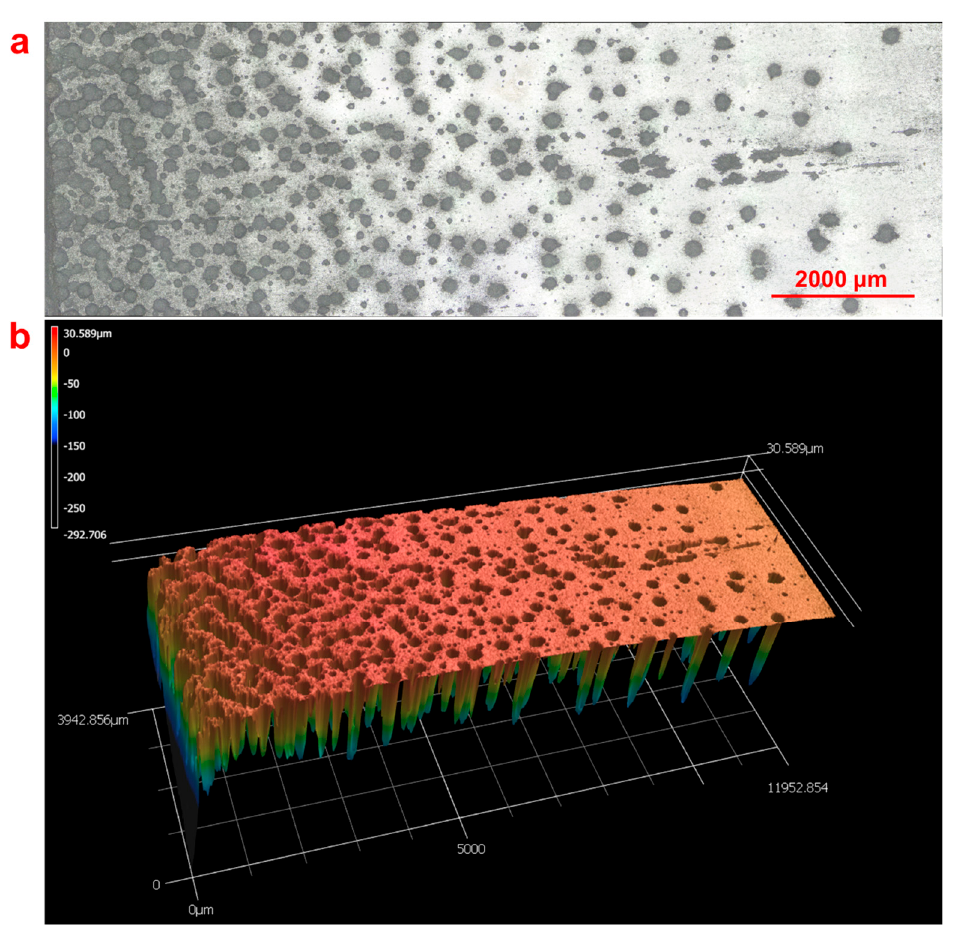
Figure 10. ( a ) The optical image of the pitting corrosion region on BPE (50 mm), and ( b ) the Figure10. ( a )TheopticalimageofthepittingcorrosionregiononBPE(50mm), and( b )thecorresponding corresponding 3D laser confocal image of this region. 3D laser confocal image of this